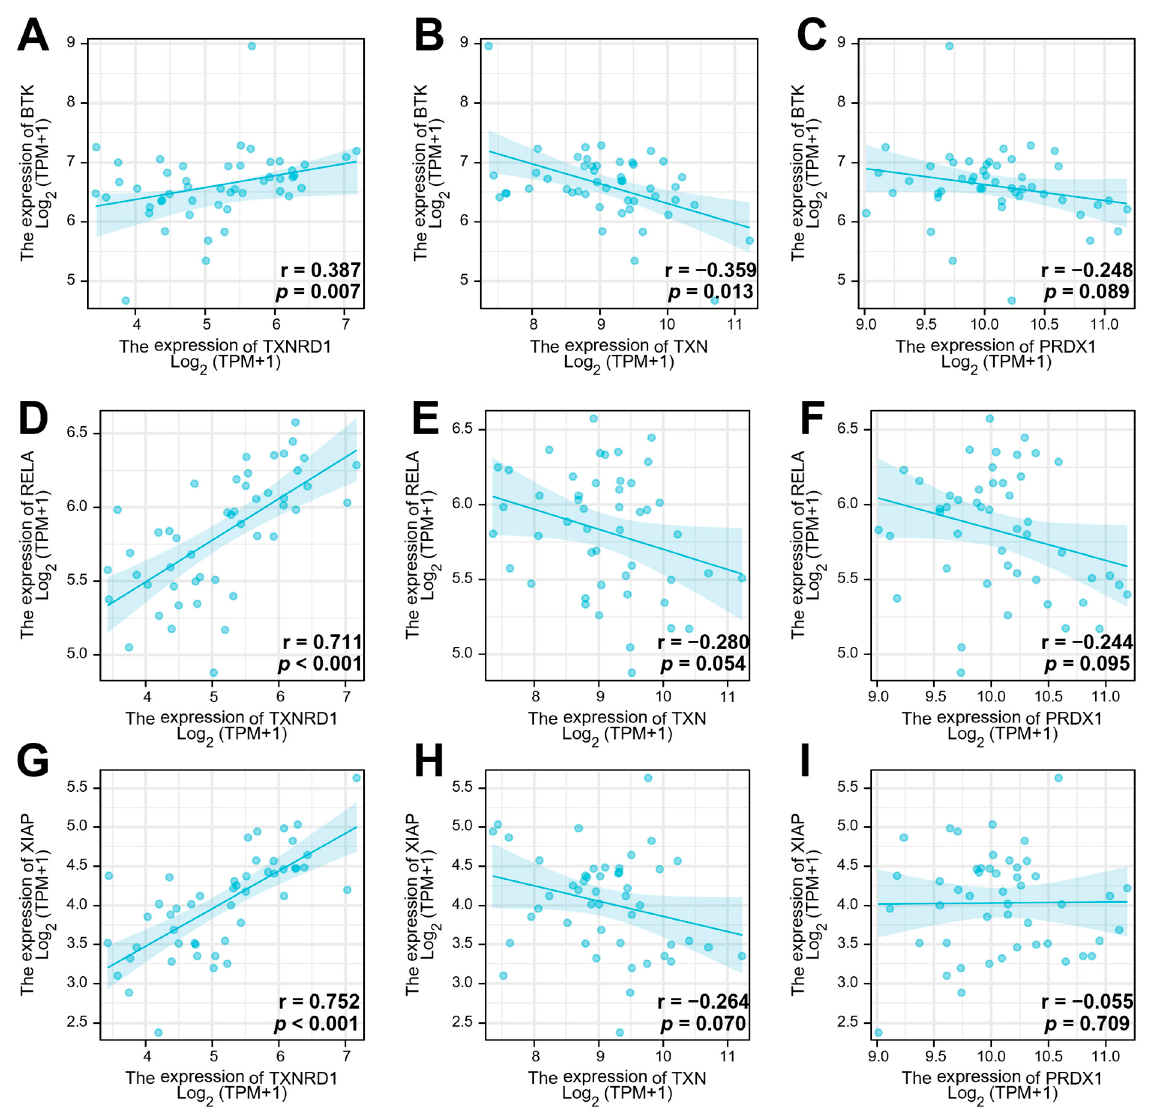
Figure 2. Correlation analysis of expression of genes of the Trx system and BCR signalling pathway. Expression of TXNRD1, TXN, and PRDX1 in comparison with BTK, RelA, and XIAP expression in DLBCL ( n = 48). ( A – C ), correlation analysis between BTK and TXNRD1 ( A ), TXN ( B ), and PRDX1